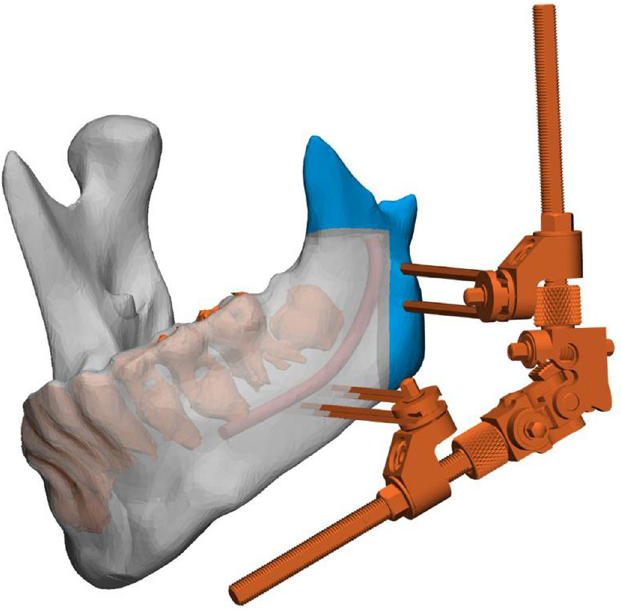
Fig. 2. Virtual distractor planning. Image taken by the Dolphin 5.0 ®